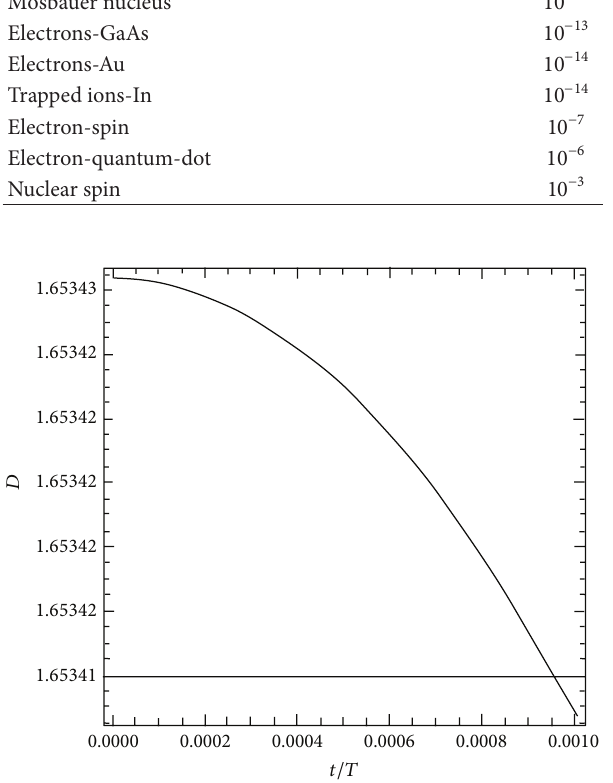
Figure 2: Quantum discord of (4) as a function of the 𝑡/𝑇 where 𝑡 is thetimeand 𝑇 isthescaleoftimewherethenonclassicalcorrelations prevail. The interval considered is 0 ≤ 𝑡/𝑇 ≤ 10 −3 and the value of the impurity is given by